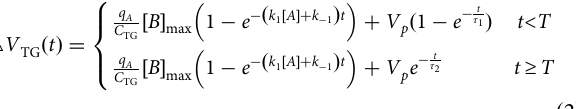
Fig. 3 Measurements of biotin – avidin bindings using SLB-FET. a Real-time measurement for SLB formation and sequential molecular bindings. The inset illustrates different measurement stages. b Enlarged graph in a showing binding selectivity to avidin. c Real-time traces (circle) from biotin – avidin binding at different concentrations. Dashed lines represent fi ts by an analytical model. d Response amplitudes as a function of avidin concentration in the presence (orange)/absence (gray) of the SLB. The reported values of the SLB experiment represent the mean ± standard deviation (SD) for n = 3 independent experiments. e Electron density pro fi le of supported lipid bilayer with different OB ionic concentrations obtained from the MD simulation. f Δ V TG at different concentrations of B-PE expression in the SLB with the constant number of avidin binders. The reported values of the SLB experiment represent the mean ± standard deviation (SD) for n = 3 independent experiments. g MD simulation results of ion distribution of (Na + and Cl − ) at different concentrations. Note that signi fi cant Na + peaks at z = 10 and 50 Å results from the lipid head group of the B-PE. h Sensor responses to 800 pM-avidin under different ionic conditions around the SLB. The measurement was performed for n = 3 independent experiments and all reported values represent the mean ± SD. Source data are provided as a Source Data